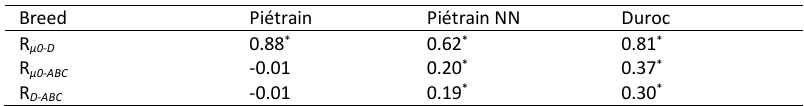
Table 3. Pearson’s correlation coefficients among the growth curve model parameters in the three pig lines analyzed Breed Piétrain Piétrain